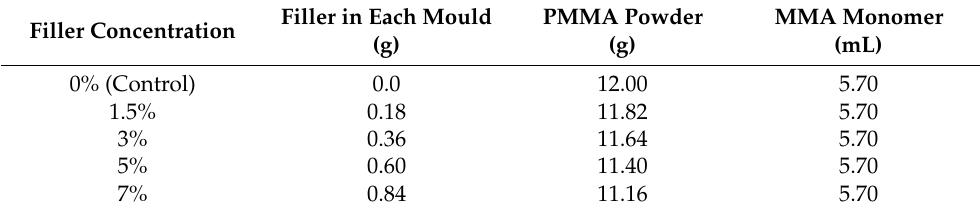
Table 3. Quantities of acrylic resin powder, monomer, and filler used in each